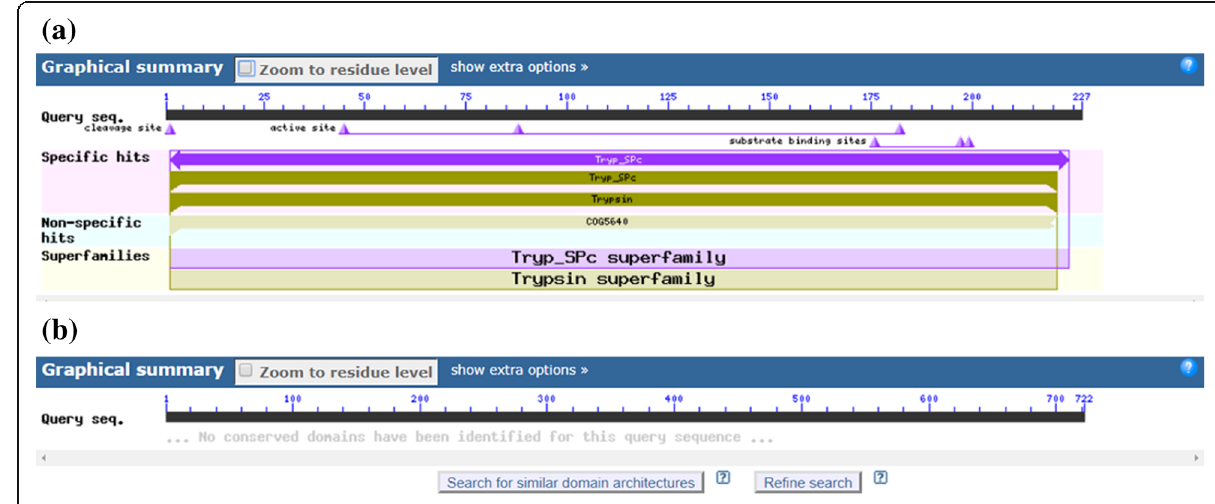
Fig. 12 a Prediction of conserved domains of cocoonase [ Bombyx mori ] on [gi|315258604|dbj|BAJ46146.1|] (serine protease with domain architecture ID 10076129) trypsin-like serine protease. Many of these are synthesized as inactive precursor zymogens that are cleaved during limited proteolysis to generate their active forms. However, a few are active as single chain molecules while others are inactive due to substitutions of the catalytic triad residues [47, 48]. Here, pfam00089 [specific hit, evalue = 2.53e − 59, trypsin] and COG5640 [non-specific hit, evalue = 9.80e − 25, secreted trypsin-like serine protease] were predicted. b Prediction of conserved domains of sericin [ Bombyx mori ]. No conserved domain was predicted